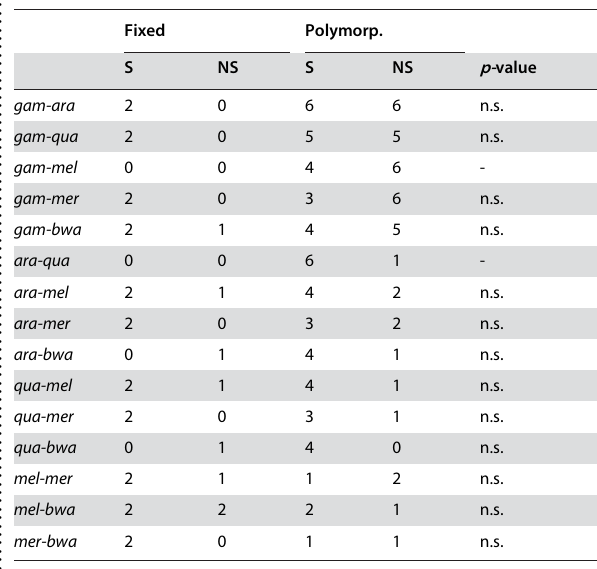
Table 2. MacDonald-Kreitman test on CEC1. ... ... ... .... ... ... .... ... ... .... ... ... .... ... ... .... ... ... .... ... ...